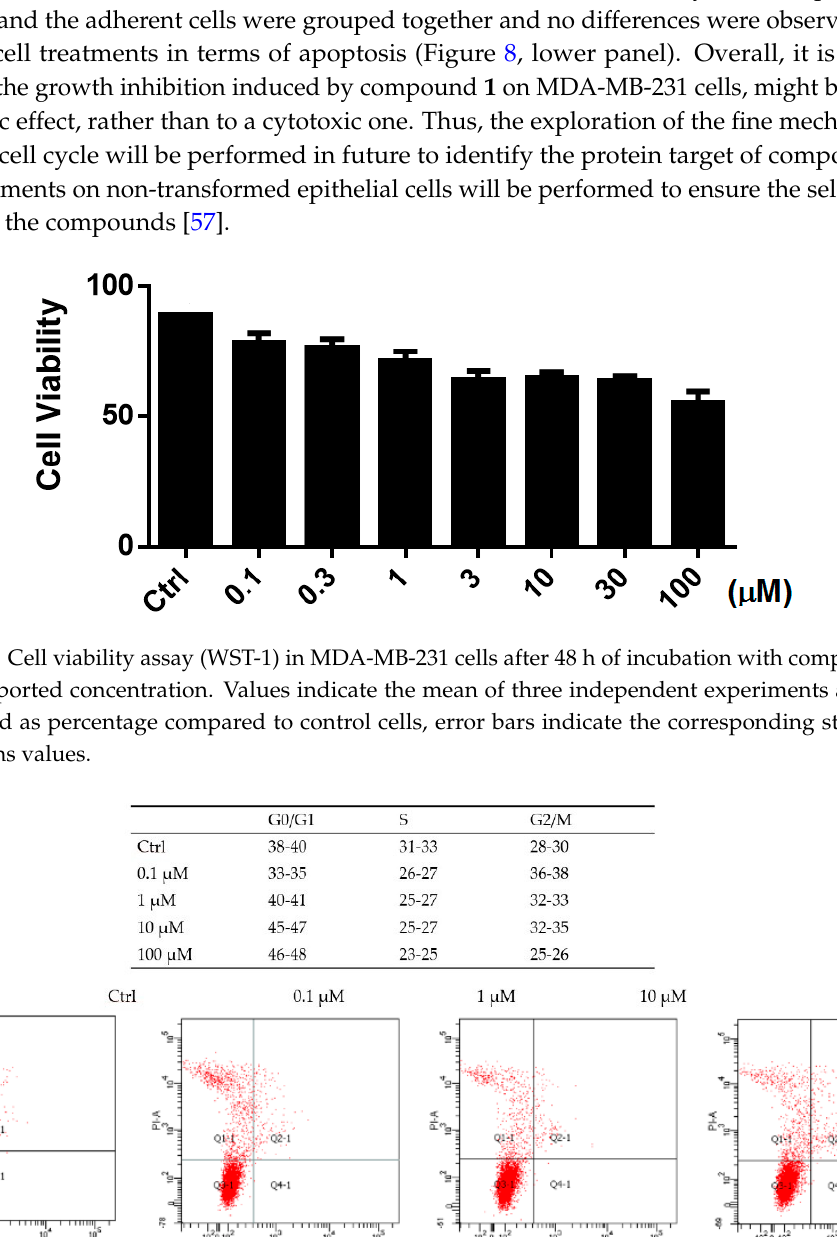
Figure 8. Cell cycle assay (upper panel) in MDA-MB-231 cells after 48 h of incubation with compound 1 at the reported concentration. Values indicate the range of cell population percentage in different cell cycle phases of three independent experiments. Apoptosis assay (lower panel) in MDA-MB-231 cells after 48h of incubation with compound 1 at the reported concentration. Representative cell plot analysis of apoptosis in MDA-MB-231.